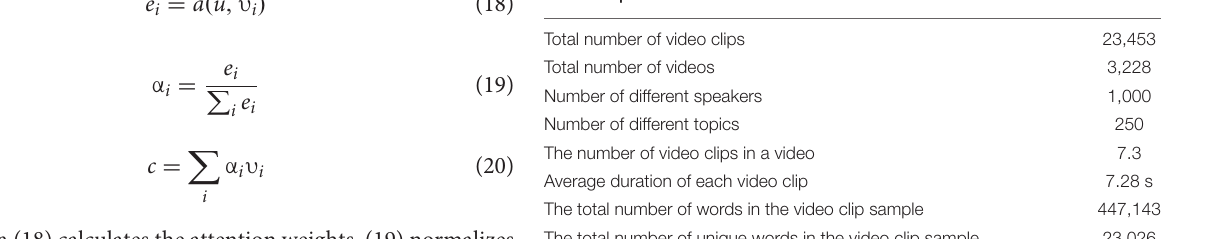
TABLE 2 | Statistical overview of the CMU-MOSEI